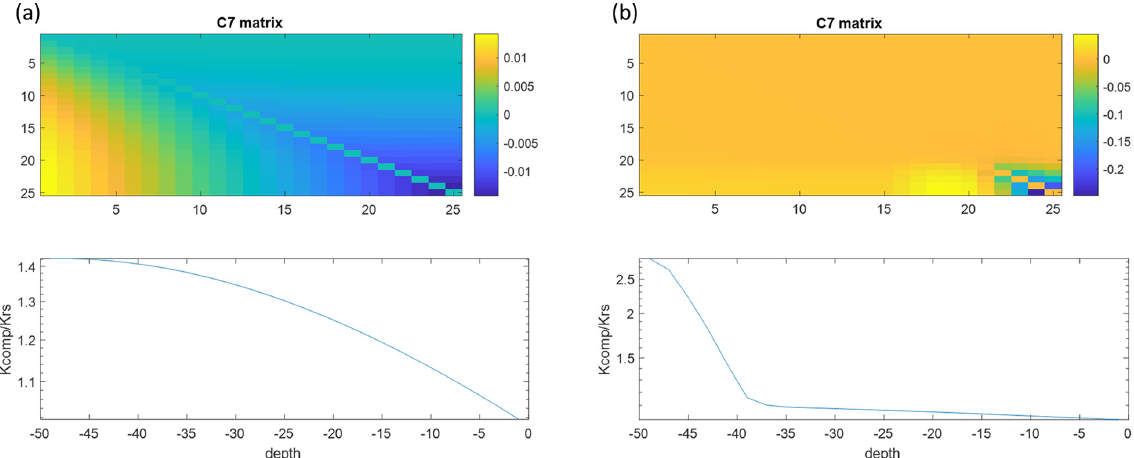
Figure 8. C 7 matrices and profiles of the ratio of K comp /K rs of the exact single root model with uniform (a) and non-uniform (b) root segment hydraulic conductances along the root. The labels on the axes of the C 7 matrices represent the root segment numbers, which increase from the proximal to the distal end of the root, i.e., from top to bottom. For visualization, the diagonal elements of the C 7 matrix were set to 0.